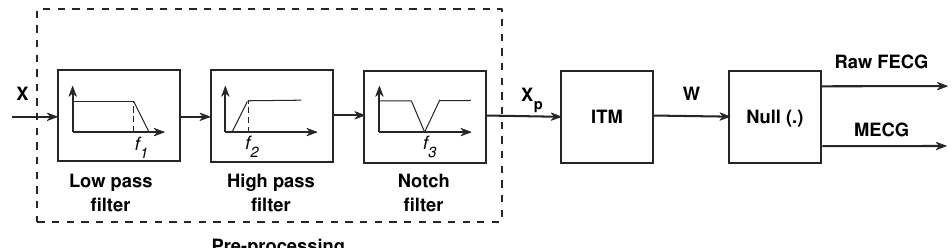
Figure 2. Raw FECG and MECG extraction system. The cut-off frequencies f 1 , f 2 , and f 3 are 100 Hz, 0.5 Hz, and 50/60